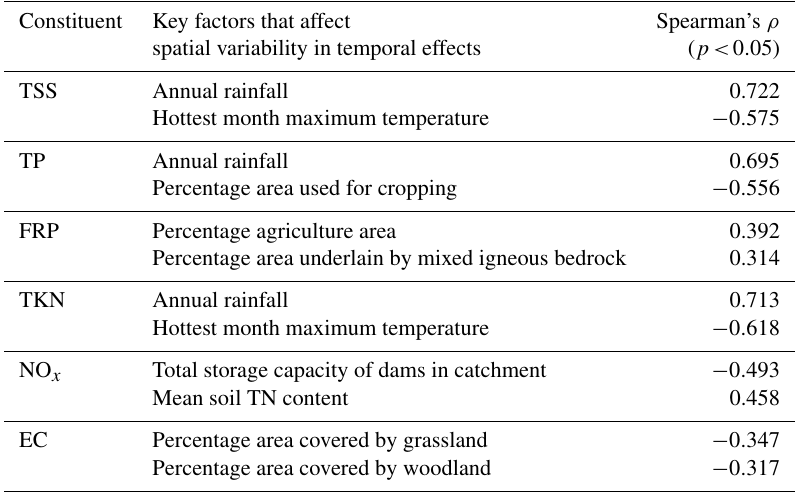
Table 2. The two key catchment landscape characteristics that were selected as predictors for the spatially varying streamflow effects in our model (see Sect. 2.3 for details regarding the selection method). The corresponding Spearman correlation ( ρ , at p< 0 . 05) between the effect of streamflow and each catchment characteristic is presented.